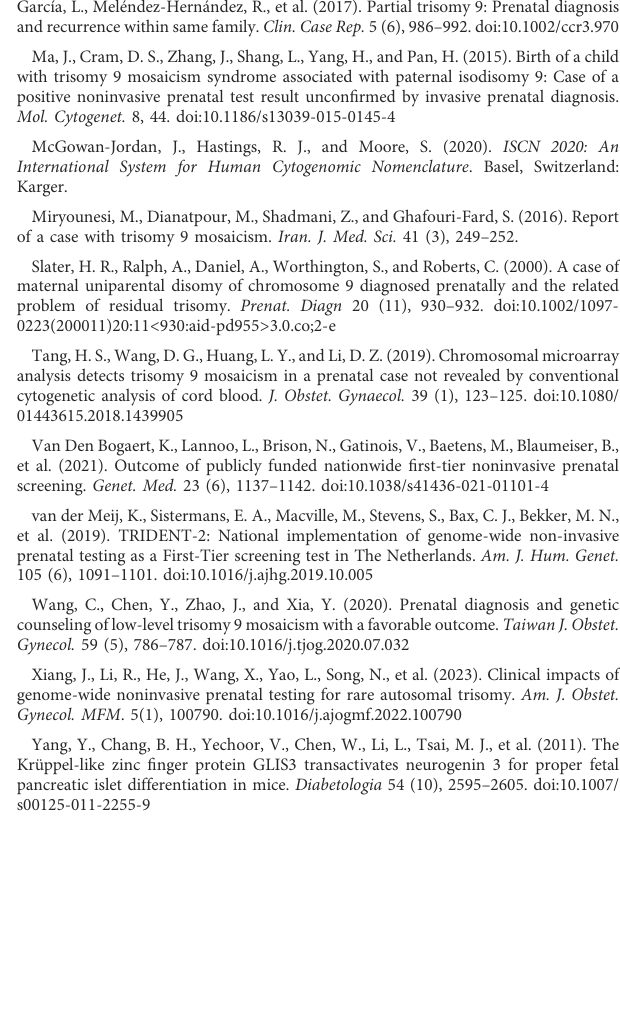
maternal center of the placenta, fetal center of the placenta, cord portion close to the placenta and cord portion close to the fetus of Case 2 with normal result, 76%, 76%, 15% and 10% trisomy 9 mosaicism, respectively. The blue line represents the mean copy number and the black box represents the centromere (x-axis: chromosomes 9; y-axis: copy number). SUPPLEMENTARY FIGURE S4 CNV-seq pro fi les of Case 2 for multiple samplings showed various levels of trisomy9.CNV-Seqpro fi lesareshownfortheheart,brain,stomach,adrenal glands, and skin of Case 2 with 20%, 10%, 8%, 6% trisomy 9 mosaicism and normal result, respectively. The blue line represents the mean copy number and the black box represents the centromere (x-axis: chromosomes 9; y-axis: copy